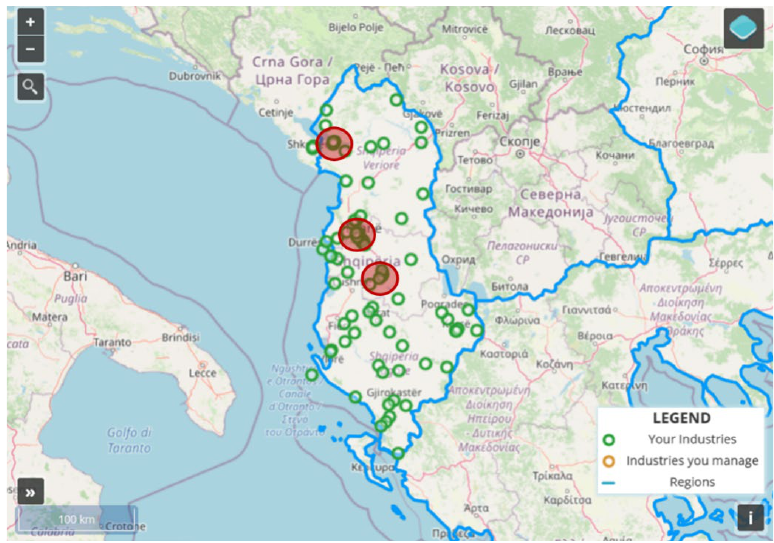
Figure 4. Identified regions for the potential development of symbiotic schemes, with the red circles in-dicating the most favorable regions for IS development (adapted screenshot from www. swanplatform.eu, accessed on 10 May